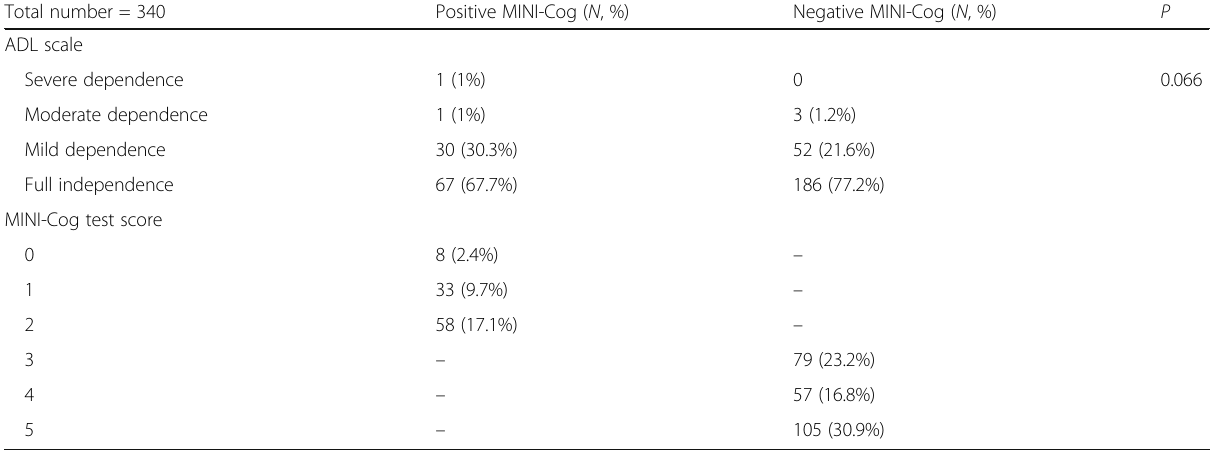
Table 1 Demographic and clinical characteristics of Hajj pilgrims with and without positive MINI-Cog test (Continued)